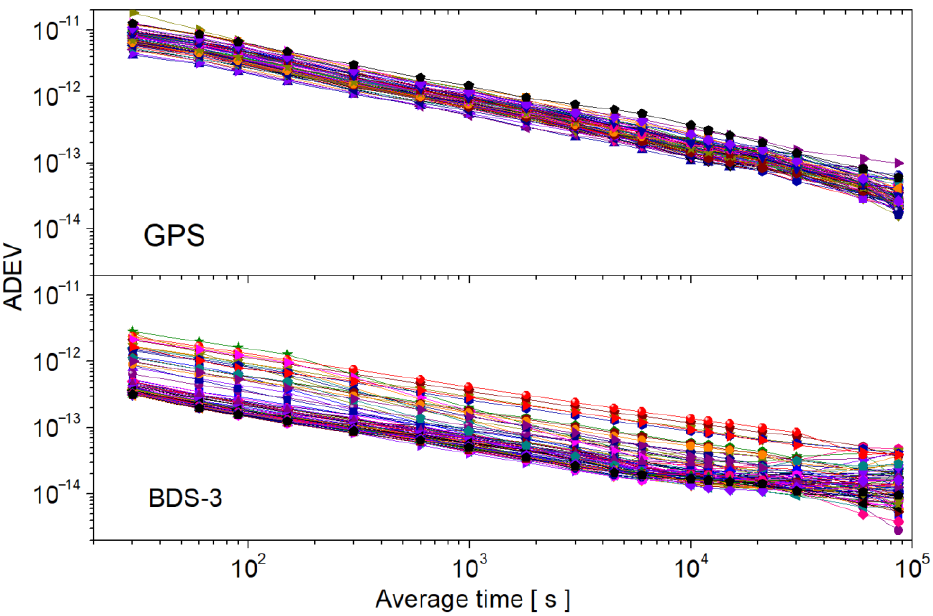
Figure 3. Allan deviation of B2b-gbm; each line represents ADEV calculated from one-week prod-